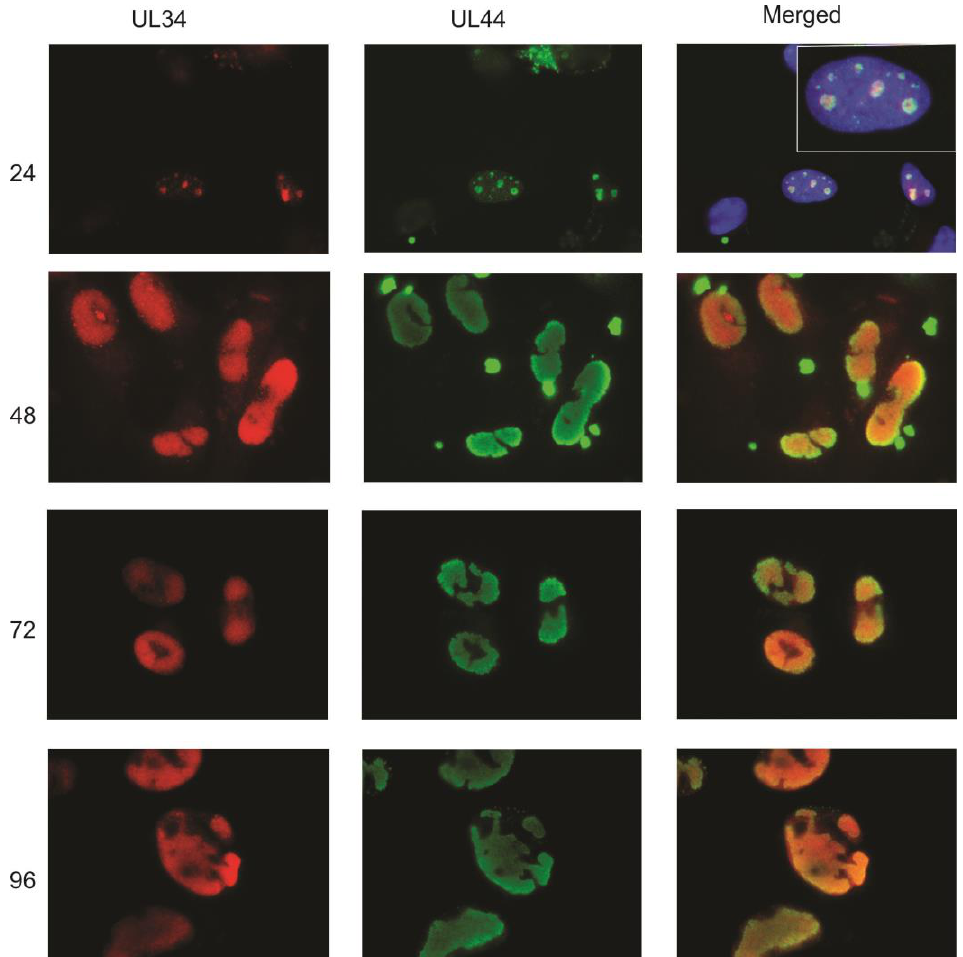
Figure 3. Indirect immunofluorescence was performed on primary human fibroblasts infected with HCMV strain Towne at 24, 48, 72, and 96 hpi using antibodies to UL34 and to UL44. UL34 staining is red, UL44 staining is green; the green and red images were merged with the DAPI-stained images (blue) at 24 hpi; for the other timepoints, only the red and green images were merged. An enlargement of one of the stained cells is shown in the insert at 24 hpi in the merged column. The extracellular bright green dots seen in the 48 hpi samples were an artifact associated with the secondary